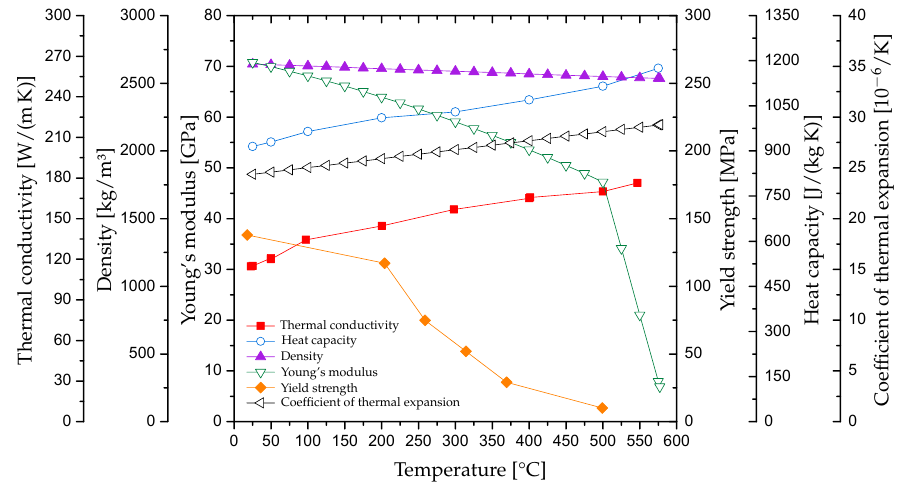
Figure 3. Temperature-dependent thermal and mechanical properties of AA5182-H111; data from